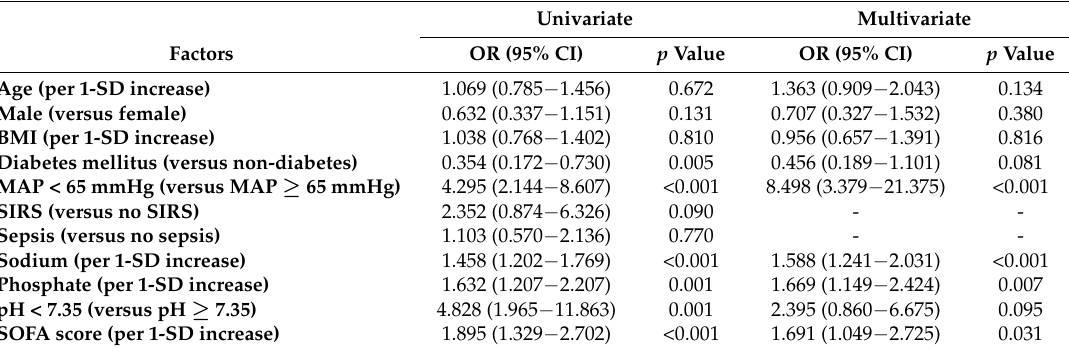
Table 4. Logistic regression analysis for very early mortality